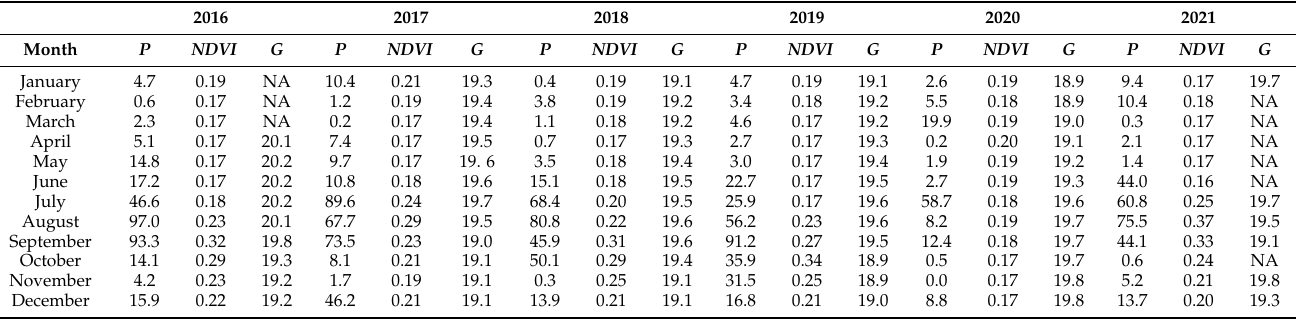
Table 2. Monthly total of precipitation ( P , in mm), monthly-average Normalized Difference Vegetation Index ( NDVI ), and monthly-average depth to groundwater ( G , in m) for years 2016–2021. NA means no data is available.